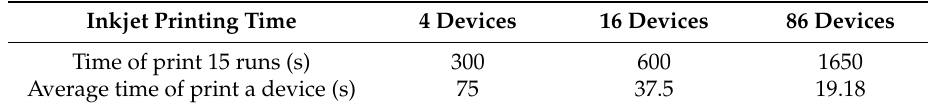
Table 1. Inkjet printing time for 4, 16, and 86 devices.